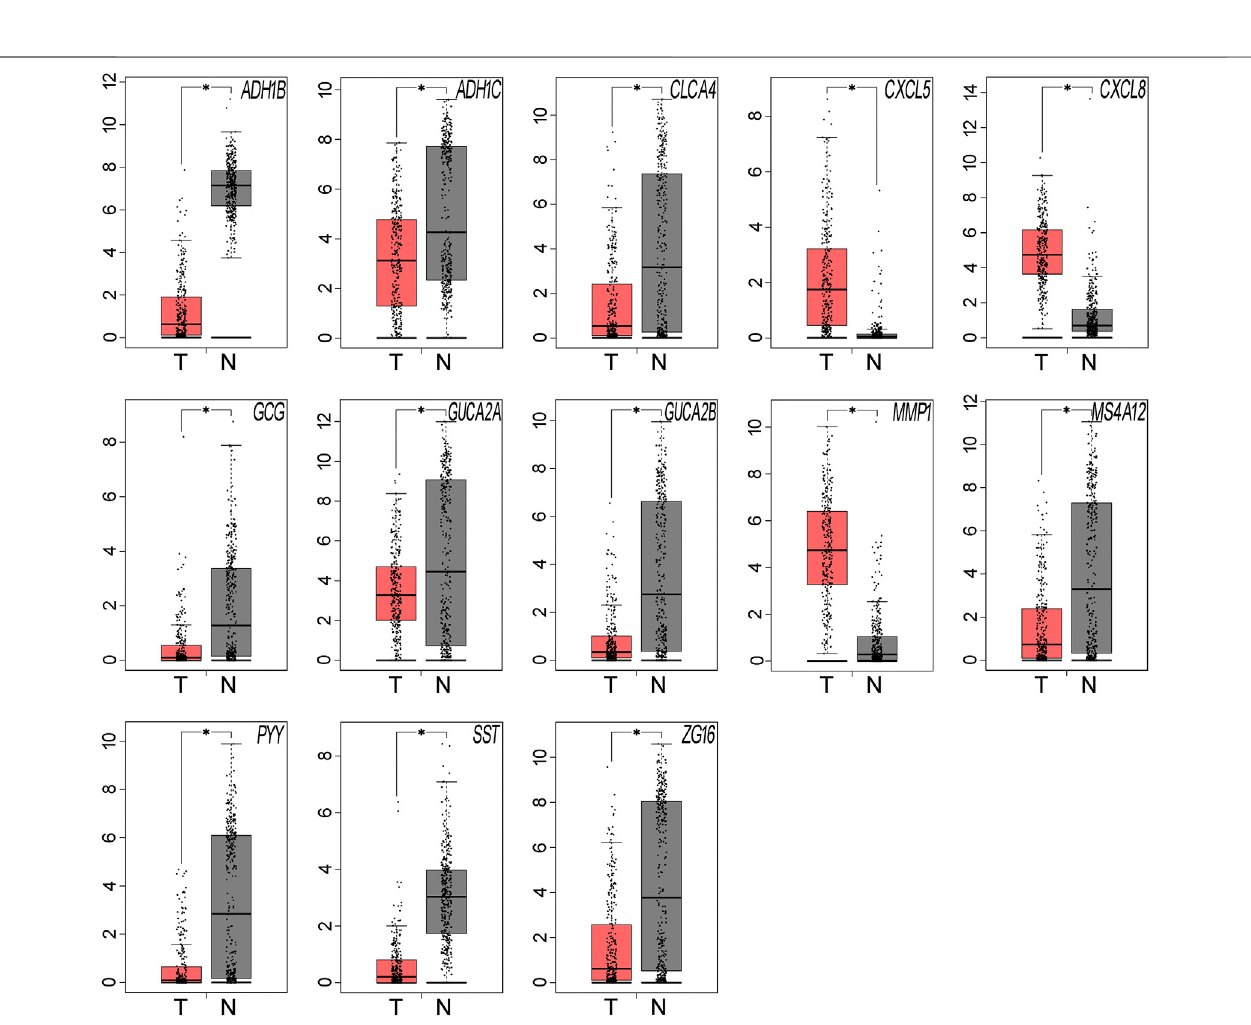
FIGURE3| TheexpressionlevelsofthehubgeneswerevalidatedusingtheGEPIAwebsite.Thirteenofthe15hubgenesshowedsigni fi cantdifferentialexpression in CRC samples, when compared with the normal samples (* P < 0.05). Red represents tumor tissues and grey represents normal tissues.